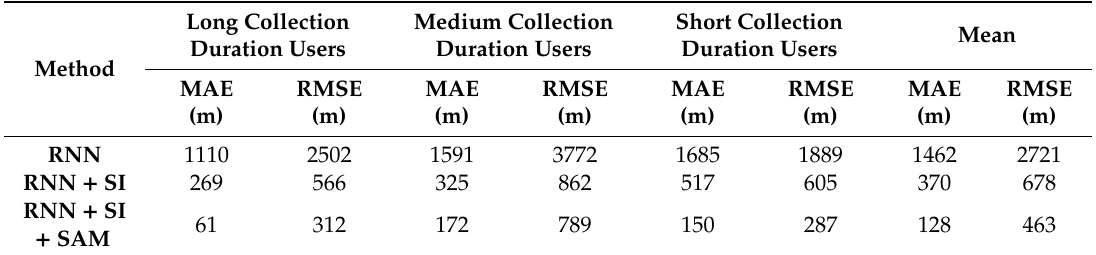
Table 5. Results of ablation experiment. SI, semantic information; SAM, self-attention mechanism.